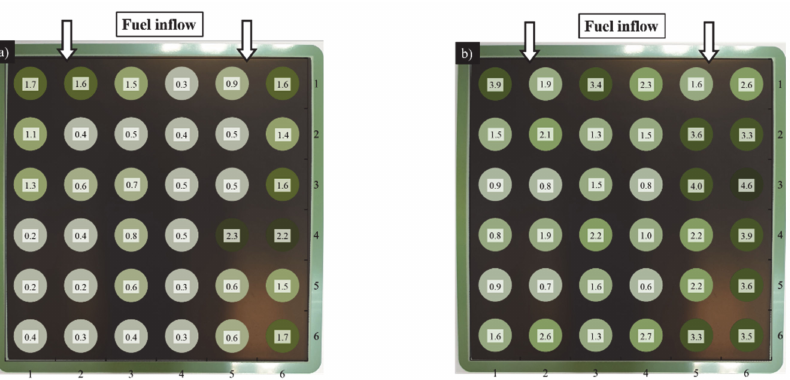
Figure 13. Si distribution and content in the Ni-YSZ layer of the SOFC ( a ) and of the SOEC ( b ). Numbers indicate Si + counts from total secondary positive ions detected at the fuel